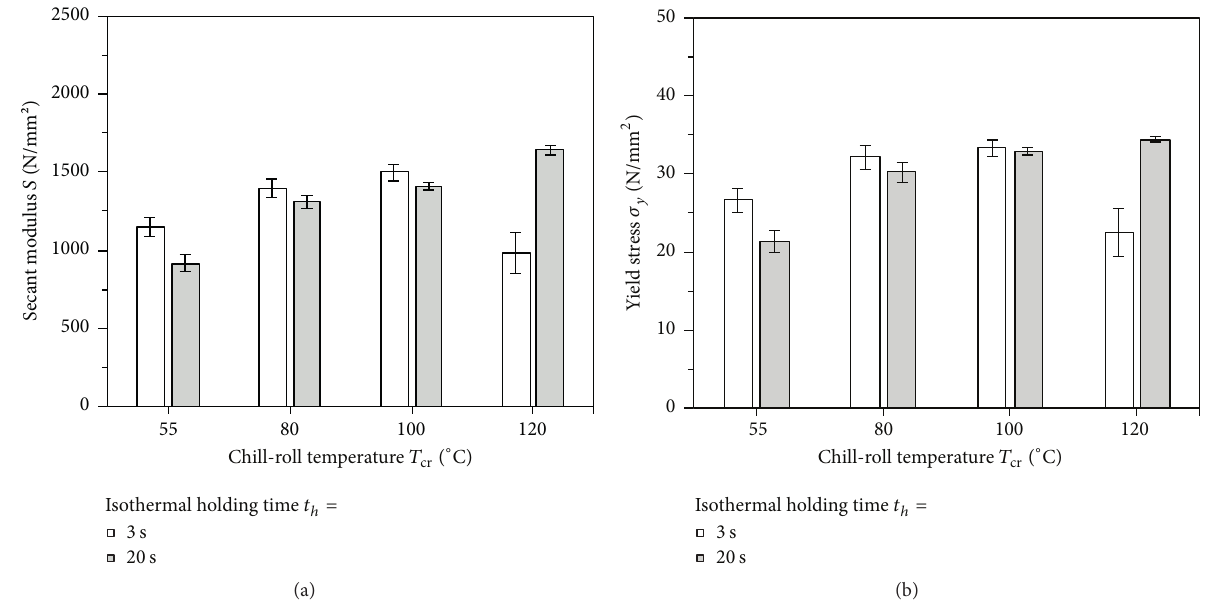
Figure 12: Secant modulus (a) and yield stress (b) of extruded foils manufactured at different chill-roll temperatures and isothermal holding times.